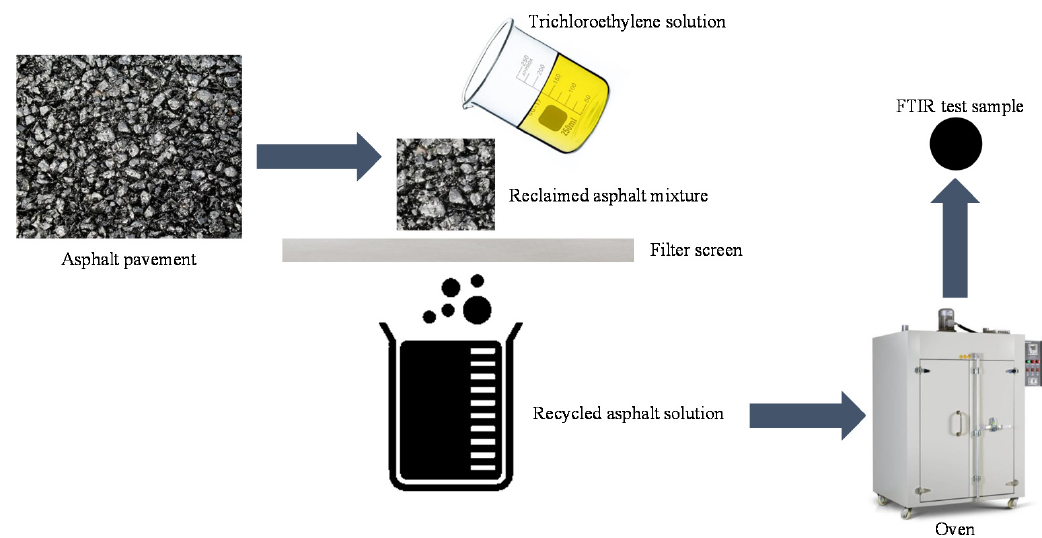
Figure 10. Method to get the FTIR spectroscopy measurement sample.